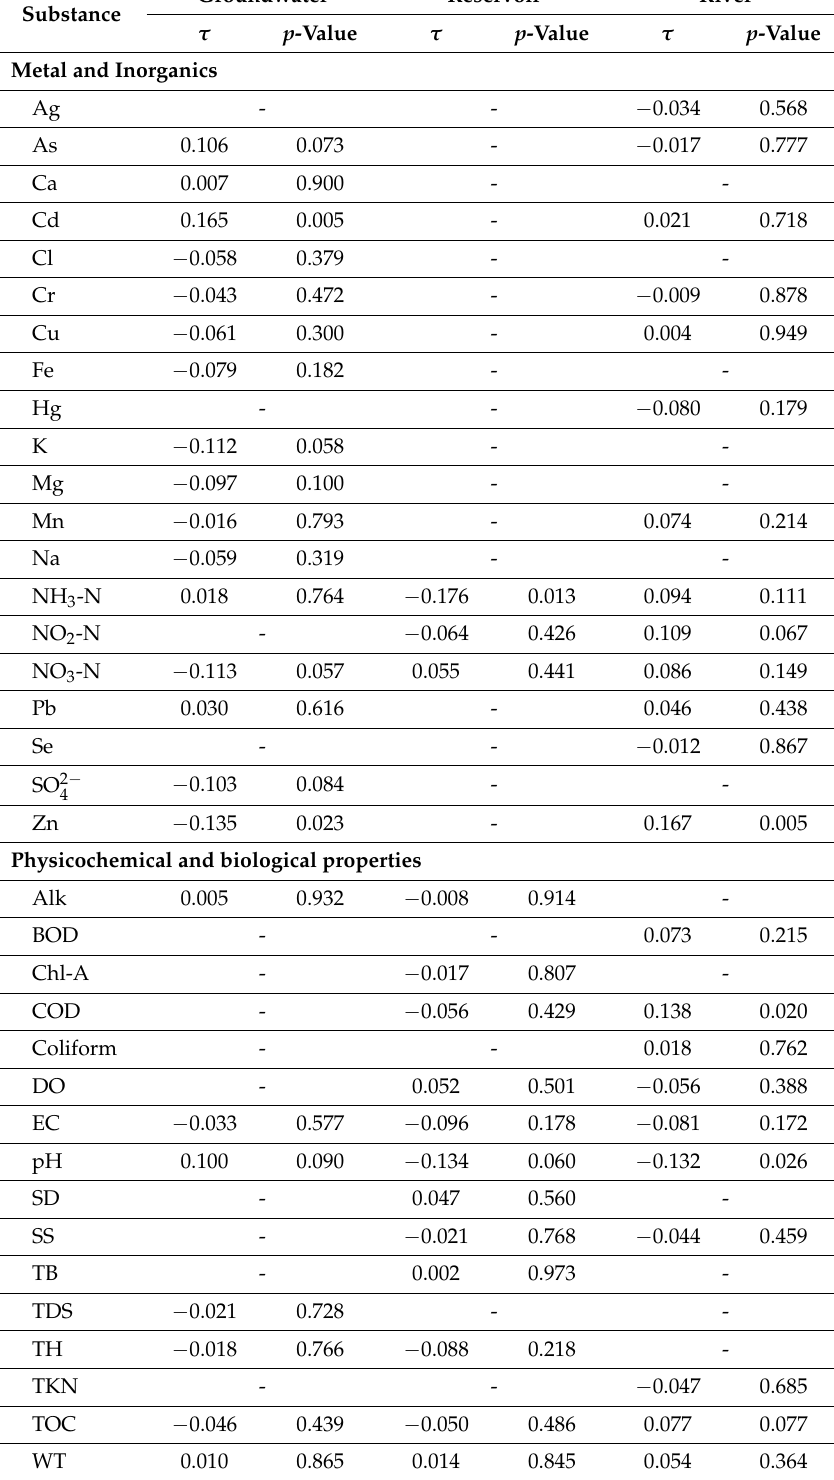
Table 3. The correlation between water attribute and age-standardized ESRD prevalence rate adjusting for gender, age, and annual effects